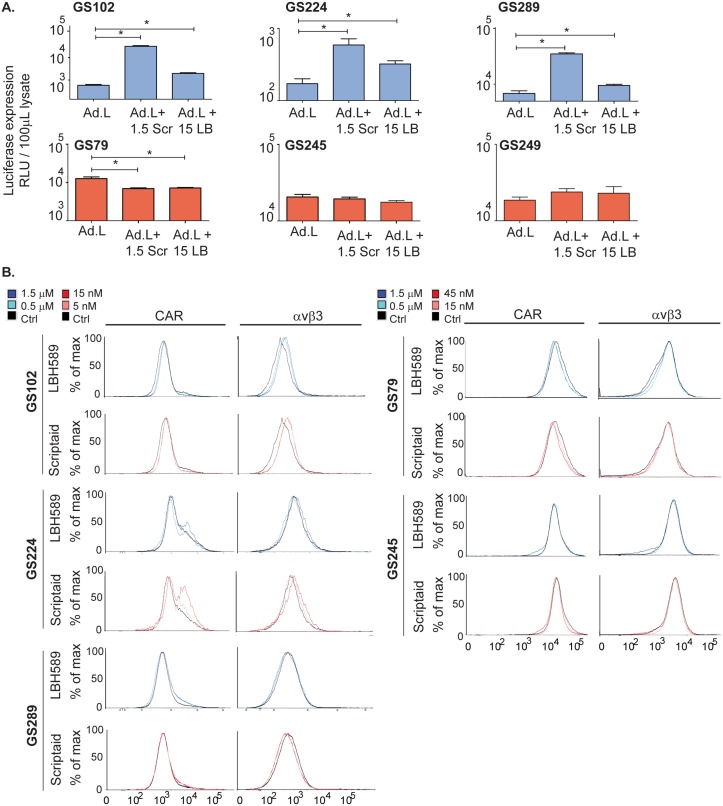
Increased Ad.luc.RGD infection and integrin levels by HDACi treatment in responding patient-derived GSC cultures.(A) Responsive GSC cultures (blue, GS102, GS224 and GS289) and resistant cultures (red, GS79, GS245 and GS249) were treated with LBH589 (LBH, 15nM) or Scriptaid (Scr, 1.5μM) and concomitantly infected with the luciferase expressing vector Ad.luc.RGD. Luciferase expression was measured after 24 hours post-infection. The results are presented as relative luciferase units (RLU)/100 μL lysate. *Indicates significance of combination treatment compared to virus alone (p<0.05). (B) The cells of three responders (left, GS102, GS224 and GS289) and two non-responders (right, GS79 and GS245) were treated with LBH589 (blue) and Scriptaid (red) as indicated. After 6 hours (S3 Fig) and 24 hours (shown) the cells were harvested and the integrin αvβ3 (left) and CAR (right) levels were determined by flow cytometry analysis.